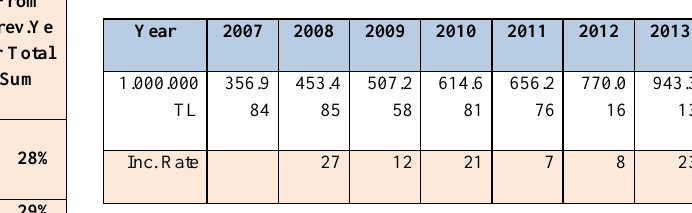
Table-10: Total Deposits in Deposit Banks, 2007-2013 (Million